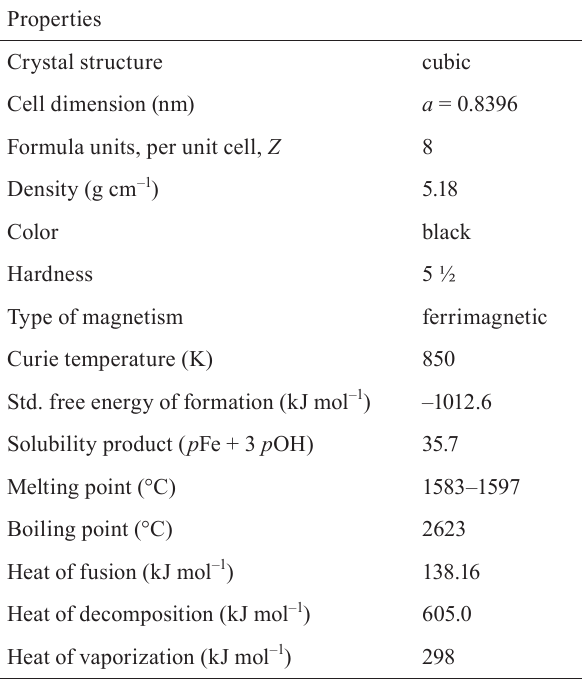
Table 1 General properties of